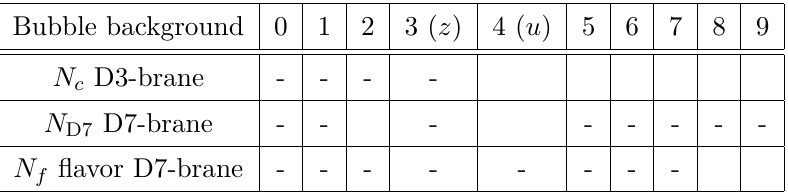
Table 4 . The D-brane configuration in the bubble